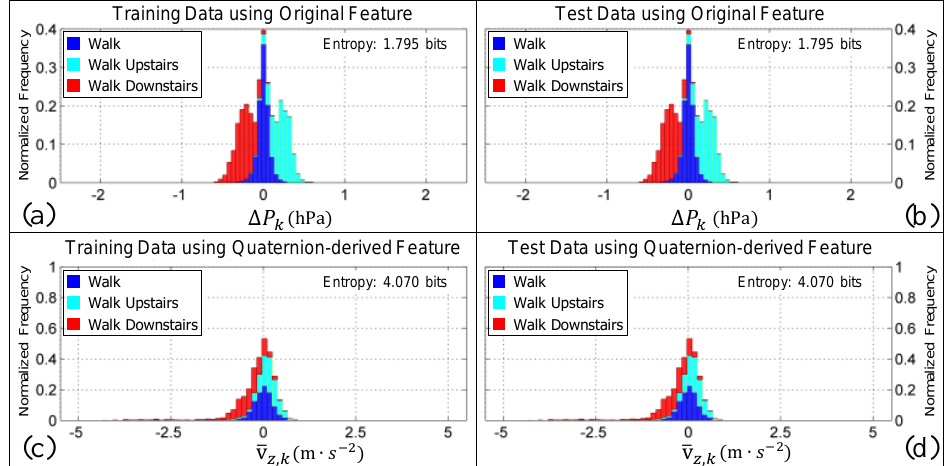
Figure 9. The normalized histograms of the walk, walking upstairs, and walking downstairs classes for the features ∆ P and ¯ v . Panels ( a , c ) are the histograms obtained when the training data are k z , k used (i.e., the data from the younger and older cohorts, respectively). Panels ( b , d ) are the histograms obtained when the test data are used (i.e., the data from the younger and older cohort after it had been re-oriented with each of the quaternions in Figure 1b–f). The bar charts in all panels are ‘stacked’. Note how the Shannon entropy of each feature remains constant whether it is computed from the training or test data (which, remember, is the training data re-oriented), confirming that both features are invariant to the initial orientation, as